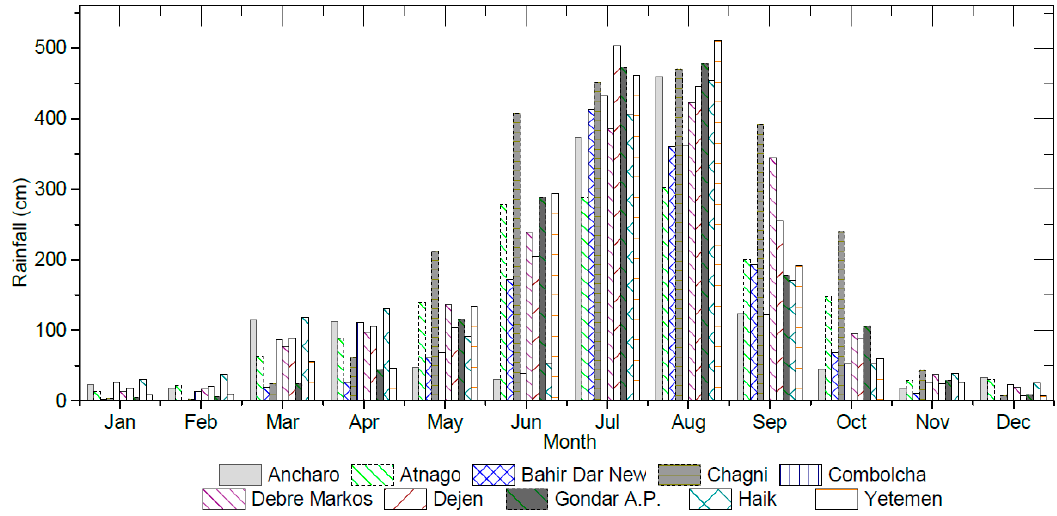
Figure 2. Monthly rainfall distribution at the ten stations over the Upper Blue Nile basin.